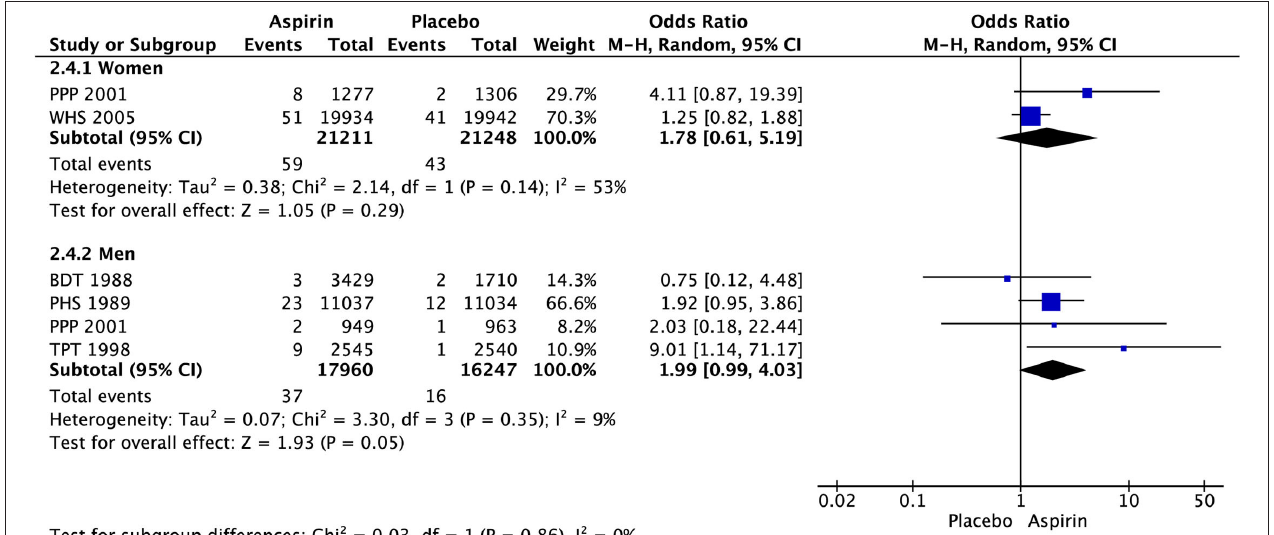
FIGURE 5 | Hemorrhagic stroke in women and men taking aspirin or